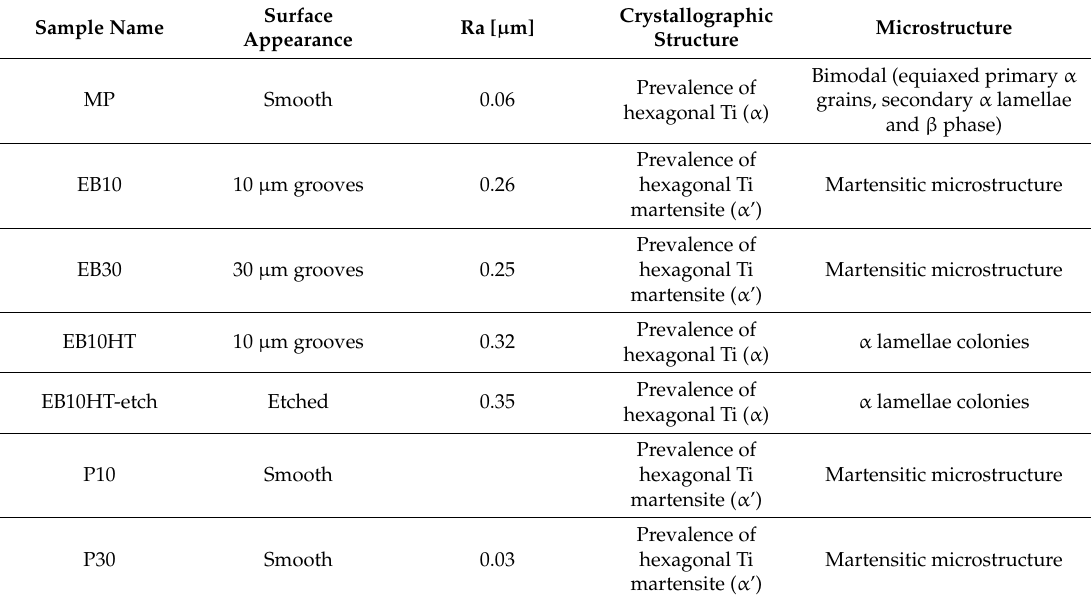
Table 2. Ti6Al4V sample topography, structure and microstructure.